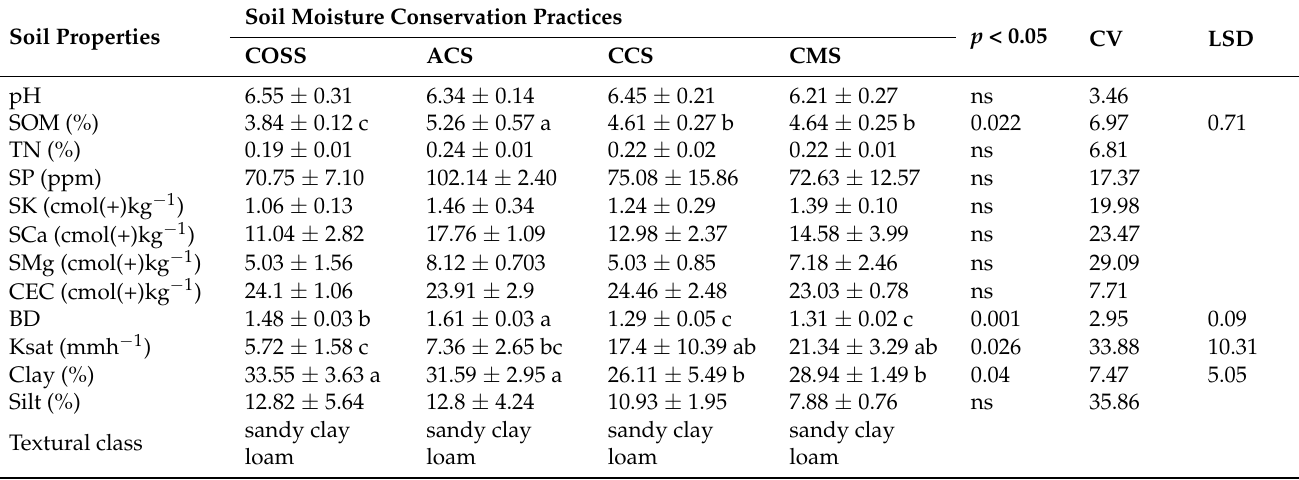
Table 1. Mean ± SD of selected soil (0–20 cm) physical and chemical properties across the four SMCPs.